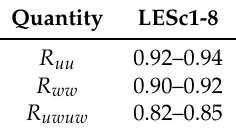
Table 6. Final correlation coefficient spatially-averaged over the each